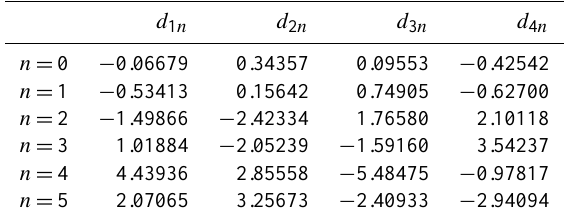
Table 2. Parameterization coefficients appearing in Eq. (27). Table 3. Parameterization coefficients appearing in Eq.